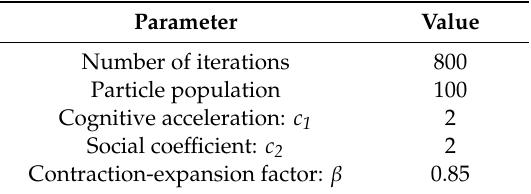
Table 5. QPSO simulation parameters with the ANFIS system for the dry turning